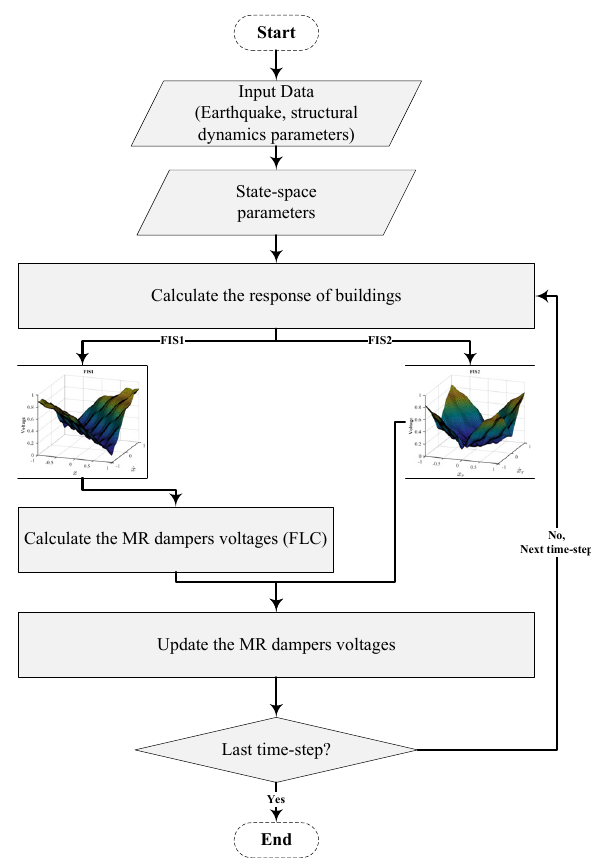
Figure 7. The flowchart of the proposed swarm-based parallel control (SPC).